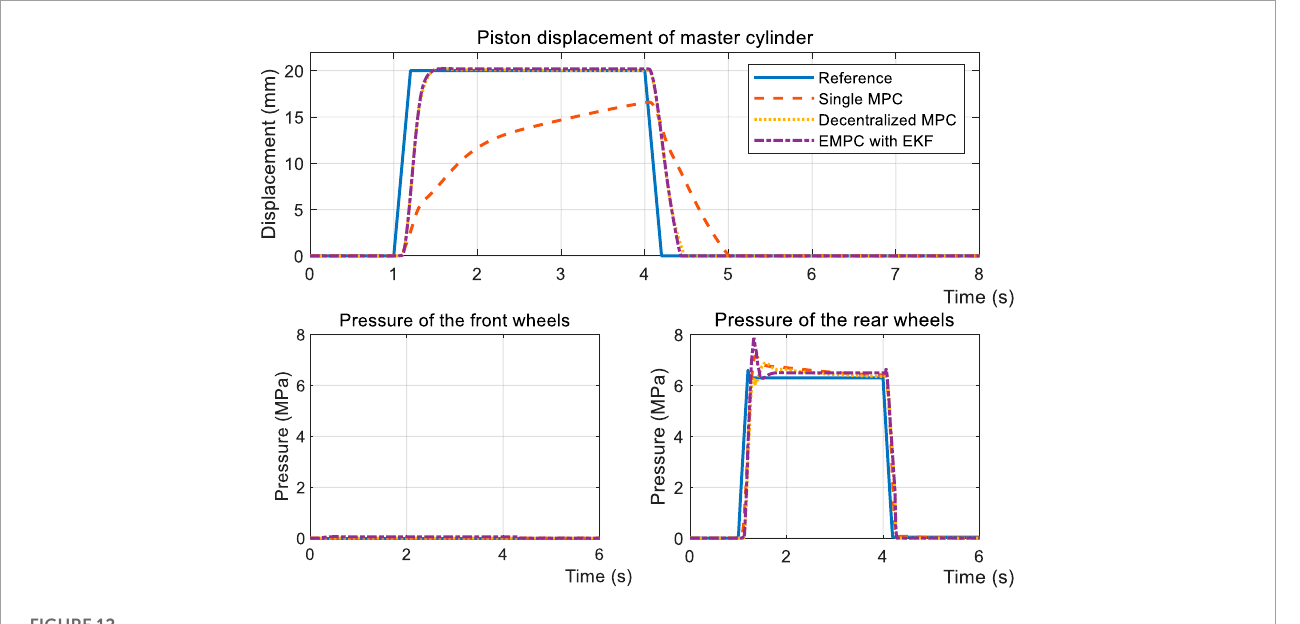
FIGURE 12 Simulation results of step response under the DEHB